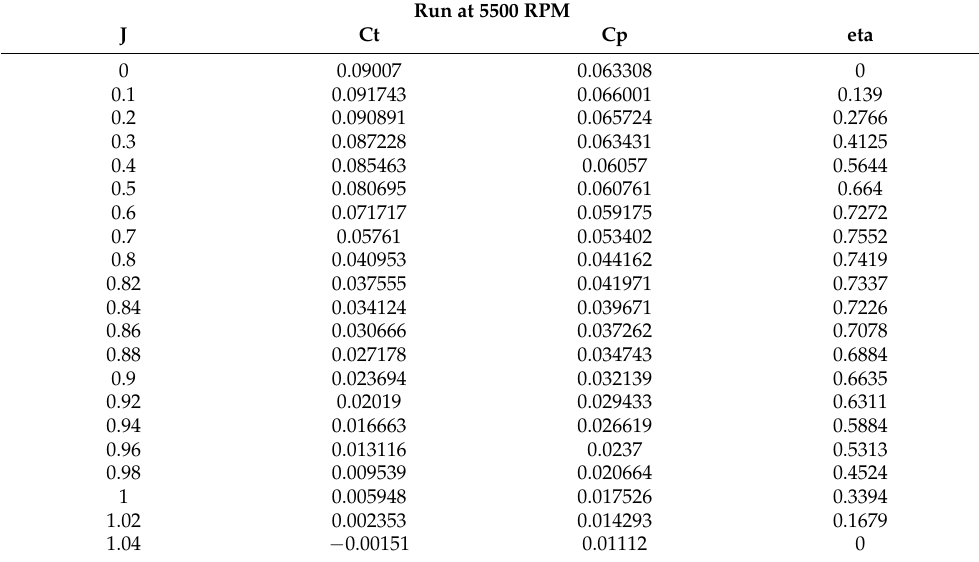
Table A30. BEMT 18 × 14 APC propeller